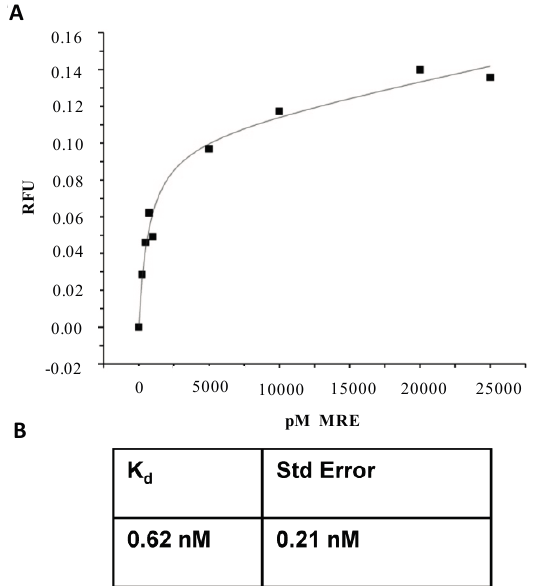
Figure 4. Fluorescent equilibrium binding assays of R12.23. Data represent K for three saturation binding curves. ( A ) Representative saturation binding curve of R12.23 with nonlinear regression best fit; ( B ) Equilibrium dissociation constant with standard error of R12.23 binding assays.